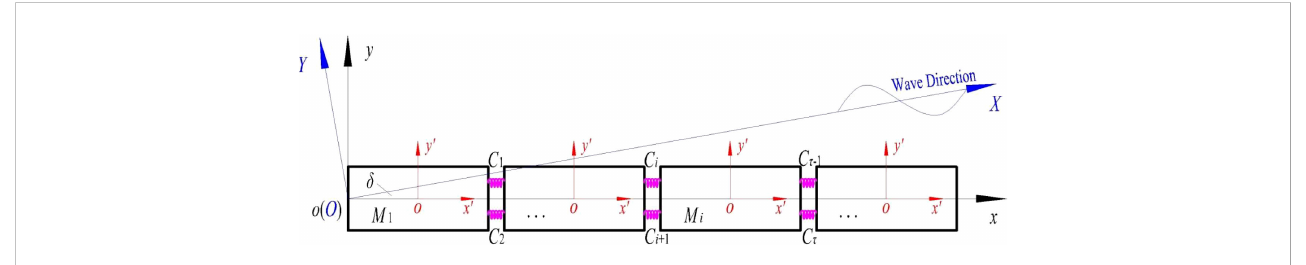
FIGURE 5 Simpli fi ed RMFC model for the module and connectors of CP-VLFS and its coordinate system ( oxy plane).